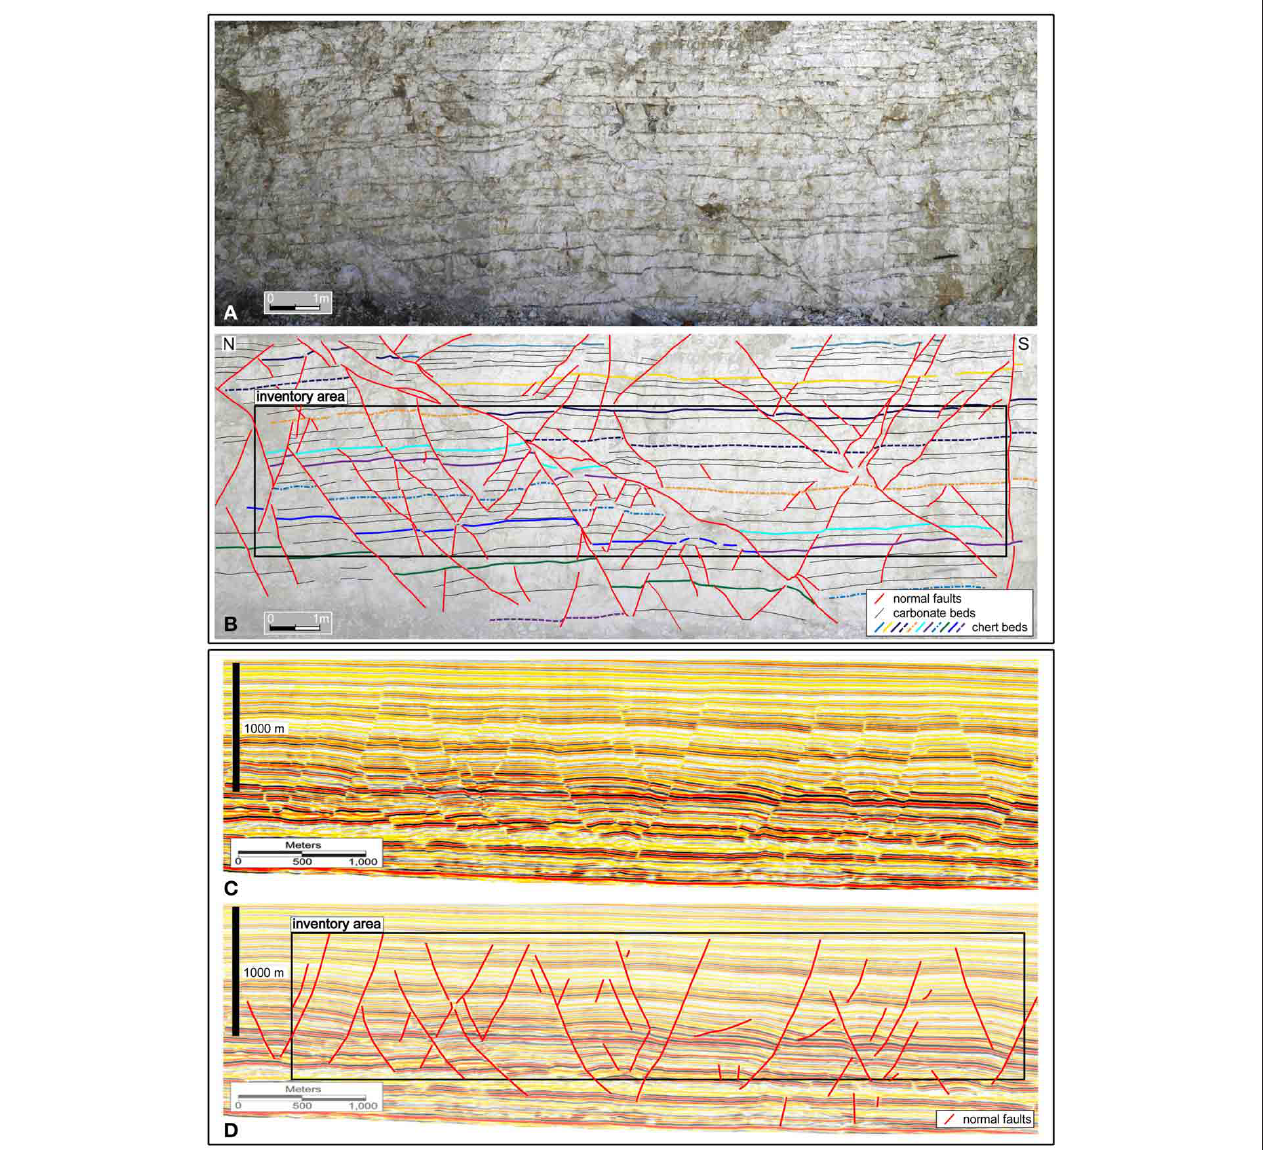
FIGURE 12 | (A) Cross-sectional view (photomosaic) of a portion of the East-Wall (Cingoli anticline; Figure 2E ). Note the normal faults and related displacements. (B) Line drawing of the previous photomosaic rectified for photographic distortions. The black rectangle is the inventory area used to calculate the fault abundance (see text). (C) Seismic reflection profile from the North Sea basin (modified from Cartwright, 2011). The profile was depth-converted using a P-wave velocity of 3000m/s that is typical of chalk (e.g., Vejbæk et al., 2005), which forms most of this cross-section. (D) Line drawing of the previous seismic profile. The black rectangle is the inventory area used to calculate the fault abundance (see text). The profile shows the characteristic structural style of a simple tier, with approximately equal numbers of mainly planar to gently listric normal faults dipping in apparent conjugate directions. The upper tips are located within two-three reflections of a common boundary; similarly for the lower tips. Note the similar structural pattern in (B,D) despite the large difference in scales.